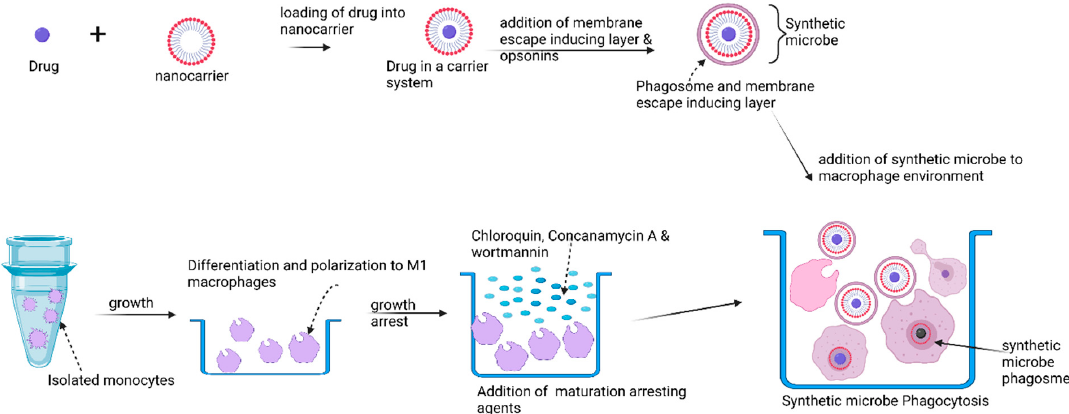
Figure 5. Formulation of the proposed synthetic microbe. Drugs are first loaded into an appropriate nanocarrier and coated with a membrane escape-inducing layer, similar to macrophage escape effector proteins in micro-organisms. The membrane-inducing layer is further coated with opsonins (a phagosome-inducing layer) to facilitate uptake by macrophages. The next step involves monocyte isolation and differentiation into M1 macrophages. They will be left to grow, but maturation will be ar- rested by the addition of chloroquine, concanamycin, and wortmannin. Maturation arrest is required to prevent the premature release of the synthetic microbes from the macrophages in vivo. The last step is the introduction of the synthetic microbe in the microphage environment to activate phagocytosis.